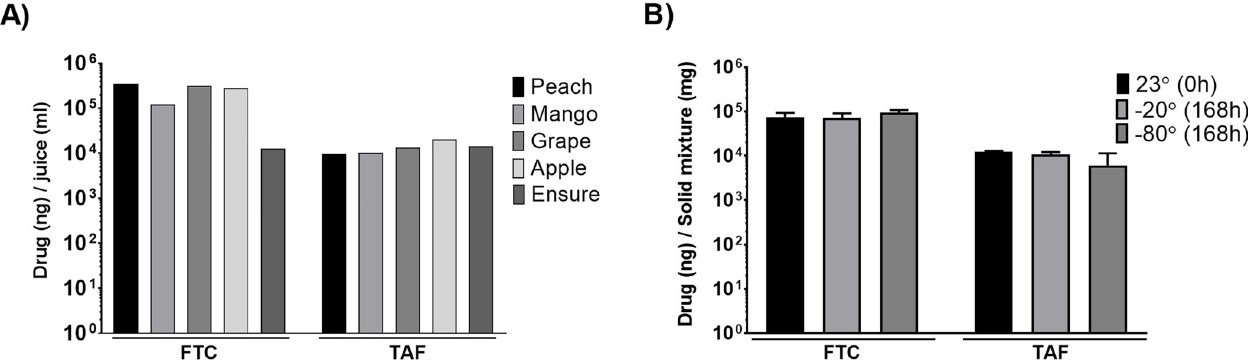
Fig 2. Drug stability in food. A) FTC and TAF stability in liquids . 200 mg of FTC, 15 mg of TAF, and 4% (w/v) natural bitterness masking powder (Fagron) were mixed into 30 ml of juice (peach, mango, grape, apple or Ensure) and vortexed until homogenous. Mixtures were tested for TAF and FTC concentrations by HPLC-MS/MS. Data is represented as ng of FTC or TAF per ml of liquid. B) FTC and TAF stability in solid foods . 200 mg of FTC, 15 mg of TAF, and 600 mg of bitterness masking powder were mixed well into 1 tablespoon of Nutella 1 or 1 tablespoon of peanut butter (PB). This mixture was divided and maintained at -20˚, or -80˚ C for one week prior to testing by HPLC-MS/MS. Control samples were made at room temperature (23˚) and analyzed immediately. Data is represented as ng of FTC/TAF per mg of solid food (PB or Nutella 1 ). Temperature and storage time had no effect on the concentrations of FTC or TAF measured by